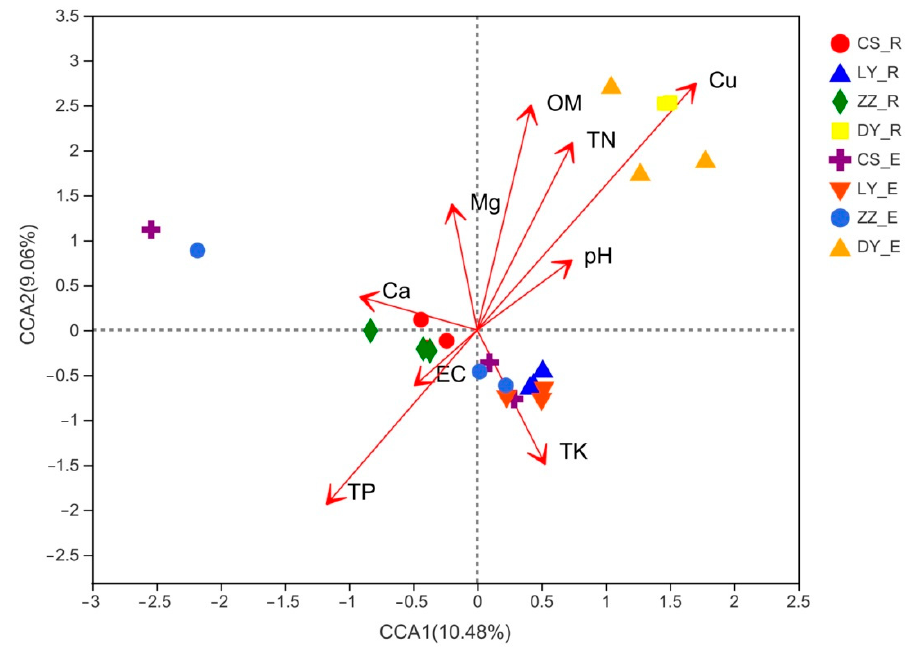
Figure 7. Canonical correspondence analysis (CCA) to show the correlations between the bacterial communities and soil physico-chemical properties. Arrows indicate the direction and magnitude of environmental parameters associated with bacterial community structure. R and E represent Rhizosphere and Endosphere, respectively.